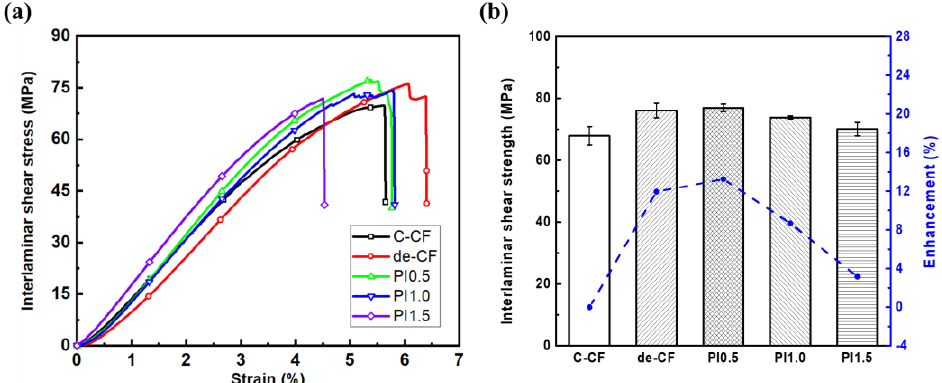
Figure 9. Interlaminar shear properties of composites reinforced with C−CFs and de−CFs, as well as PI 0.5 wt%, PI 1.0 wt%, and PI 1.5 wt% PI−sized CFs. ( a ) stress–strain curves; ( b ) interlaminar shear strengths and enhancements.